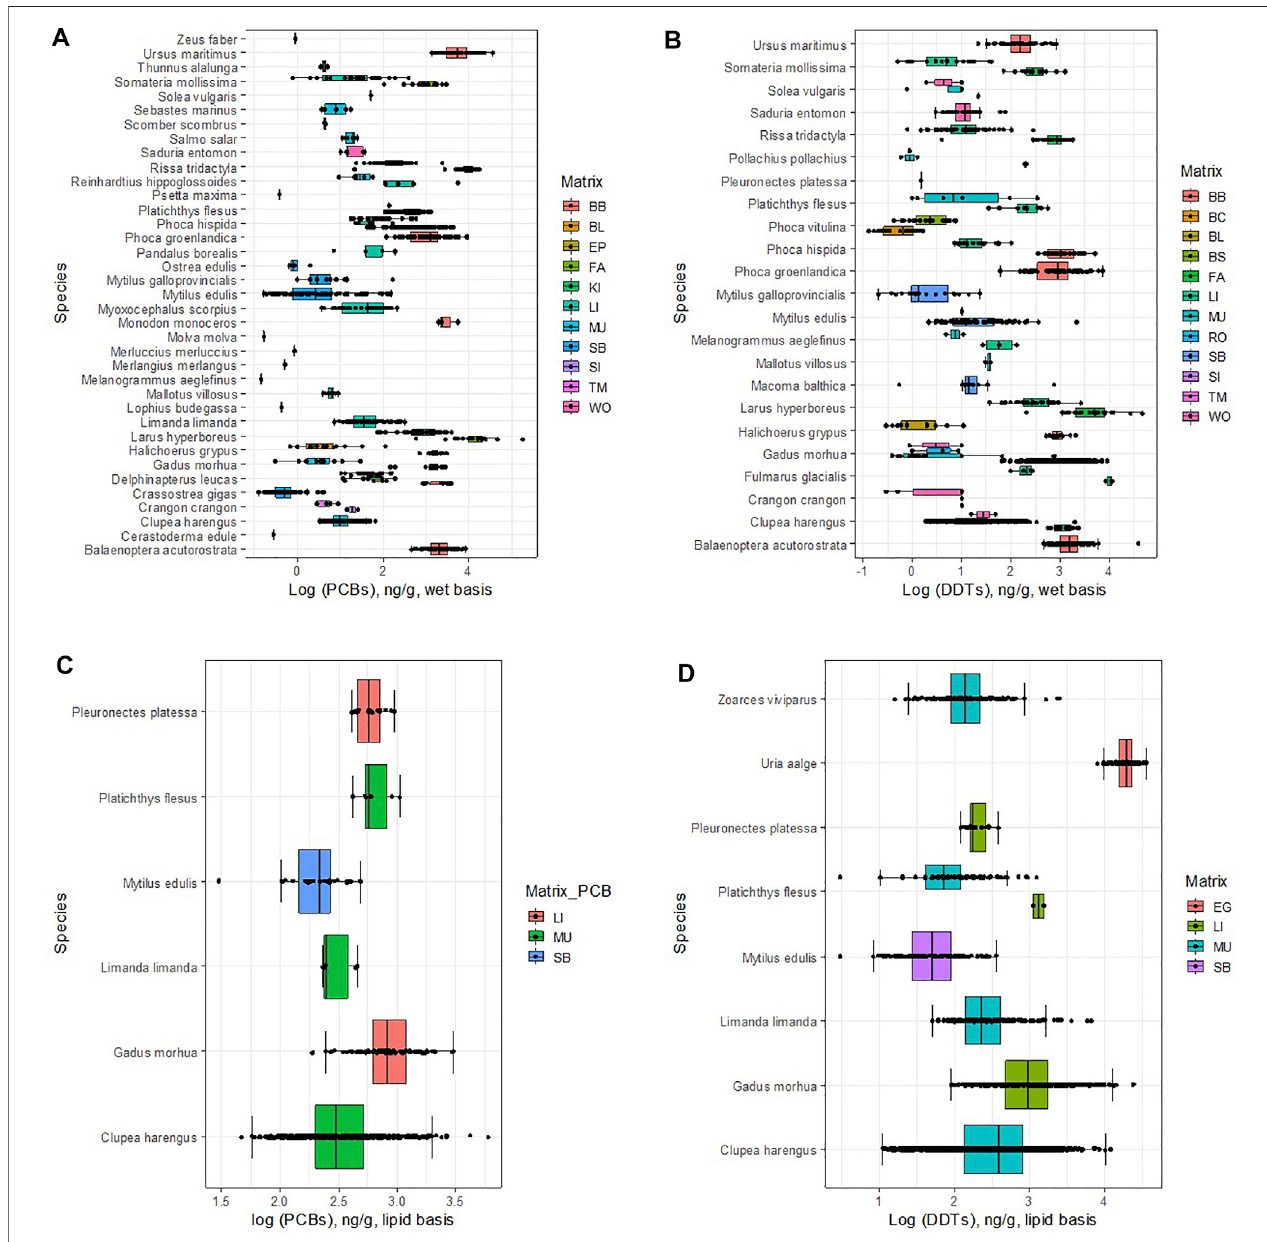
FIGURE 1 | Concentration of DDTs and PCBs in different matrices in marine organisms. Lipid basis: (A) M DDT,o,m,lipid .; (B) M PCB,o,m,lipid . Wet basis: (C) wet basis, M DDT,o,m,wet .; (D) M PCB,o,m,wet . For a list of matrix, codes see Table 1 .